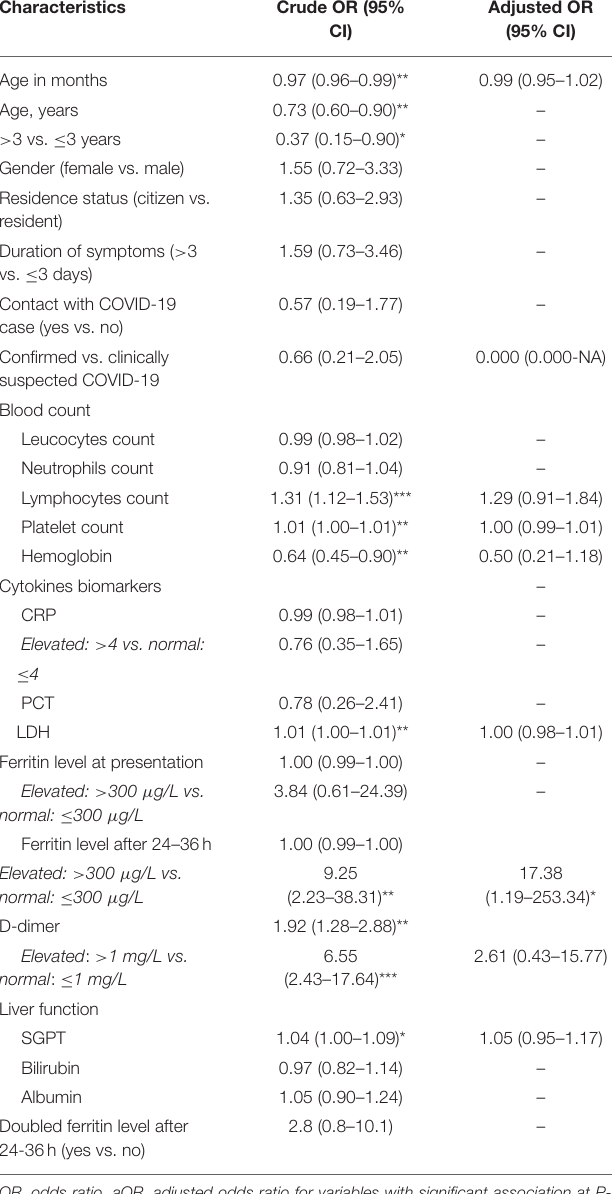
TABLE 4 | Bivariate and multivariate analysis of factors associated with severity of disease at presentation (severe vs. non-severe) among confirmed and clinically suspected COVID-19 pediatric